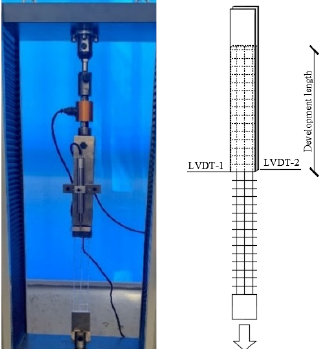
Figure 4. Pull ‐ out test and configuration. Figure 4. Pull-out test and Table 2. Summary of the results for all the test specimens.